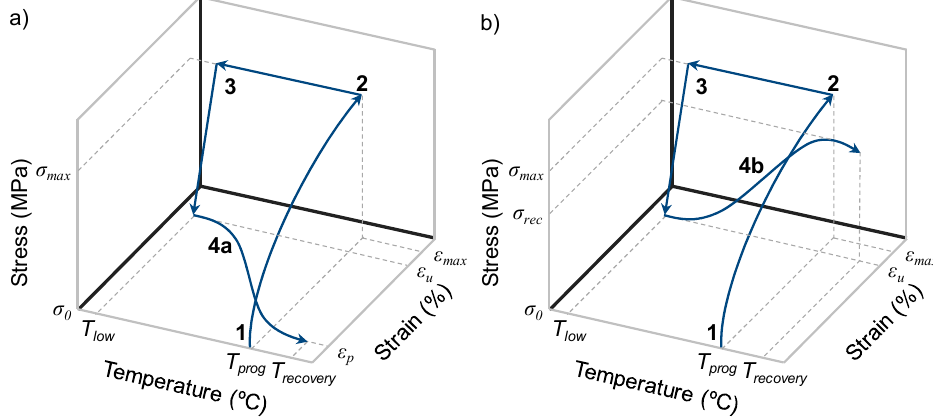
Figure 3. Schematic representation of the thermomechanical programming under free recovery conditions ( a ) and under fully constrained conditions, which generates a recovery stress ( b ).